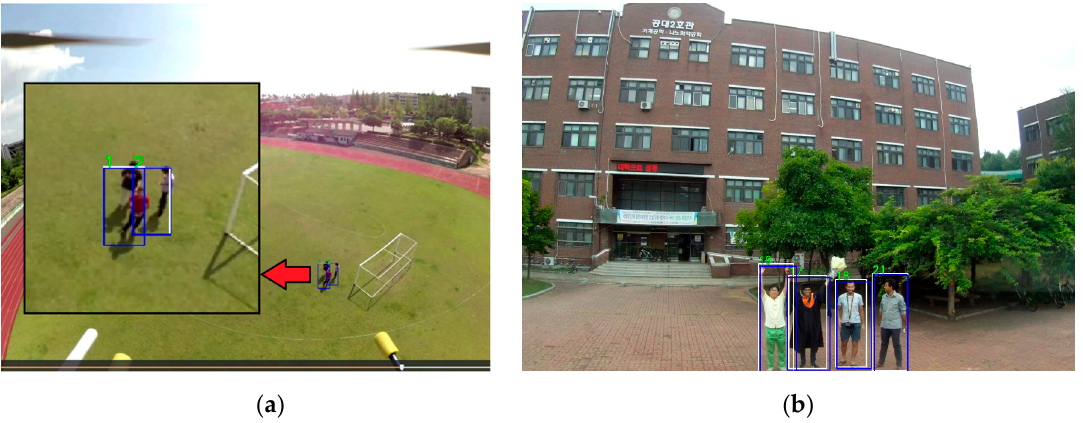
Figure 15. Target tracking results using Deep SORT and YOLOv3 from the drone using ( a ) Xavier and ( b ) the off-board GPU-based ground station.